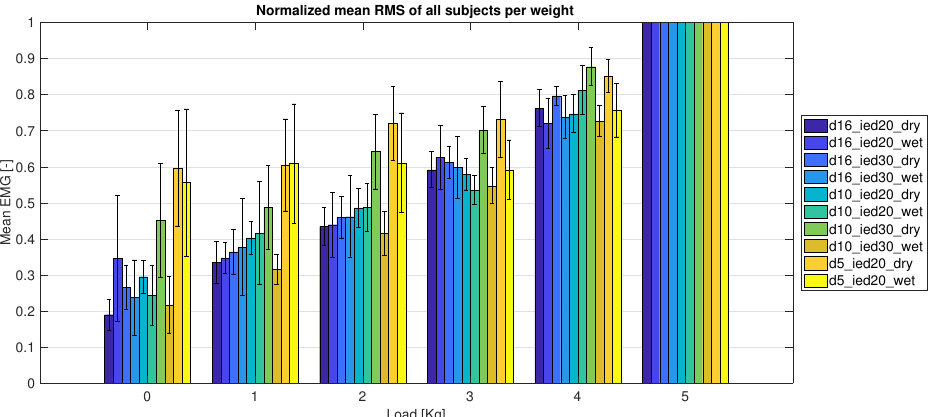
Figure 14. Mean envelope of the 5 kg load sample of each electrode size in wet and dry conditions, shown per subject.